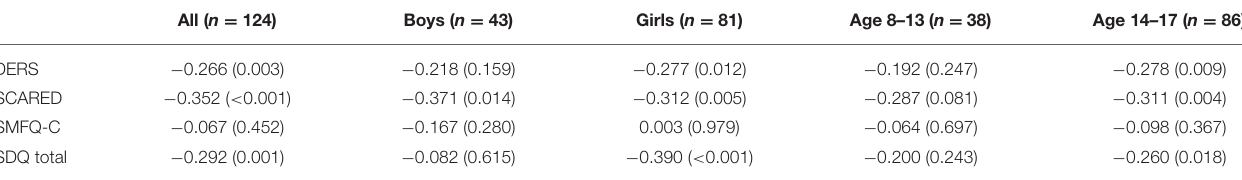
TABLE 1 | Perceived burden of COVID-19 and DERS, SCARED, SMFQ-C and SDQ-total stratified by gender and age.